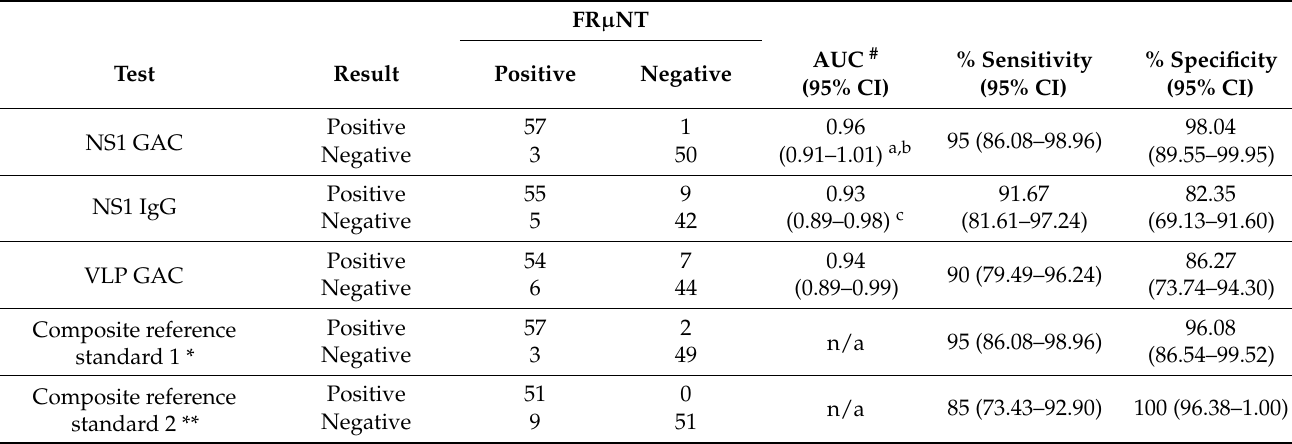
Table 2. Comparison of NS1 GAC-, indirect NS1 IgG, VLP GAC–ELISAs, and composite reference standards with FR µ NT in the determination of dengue